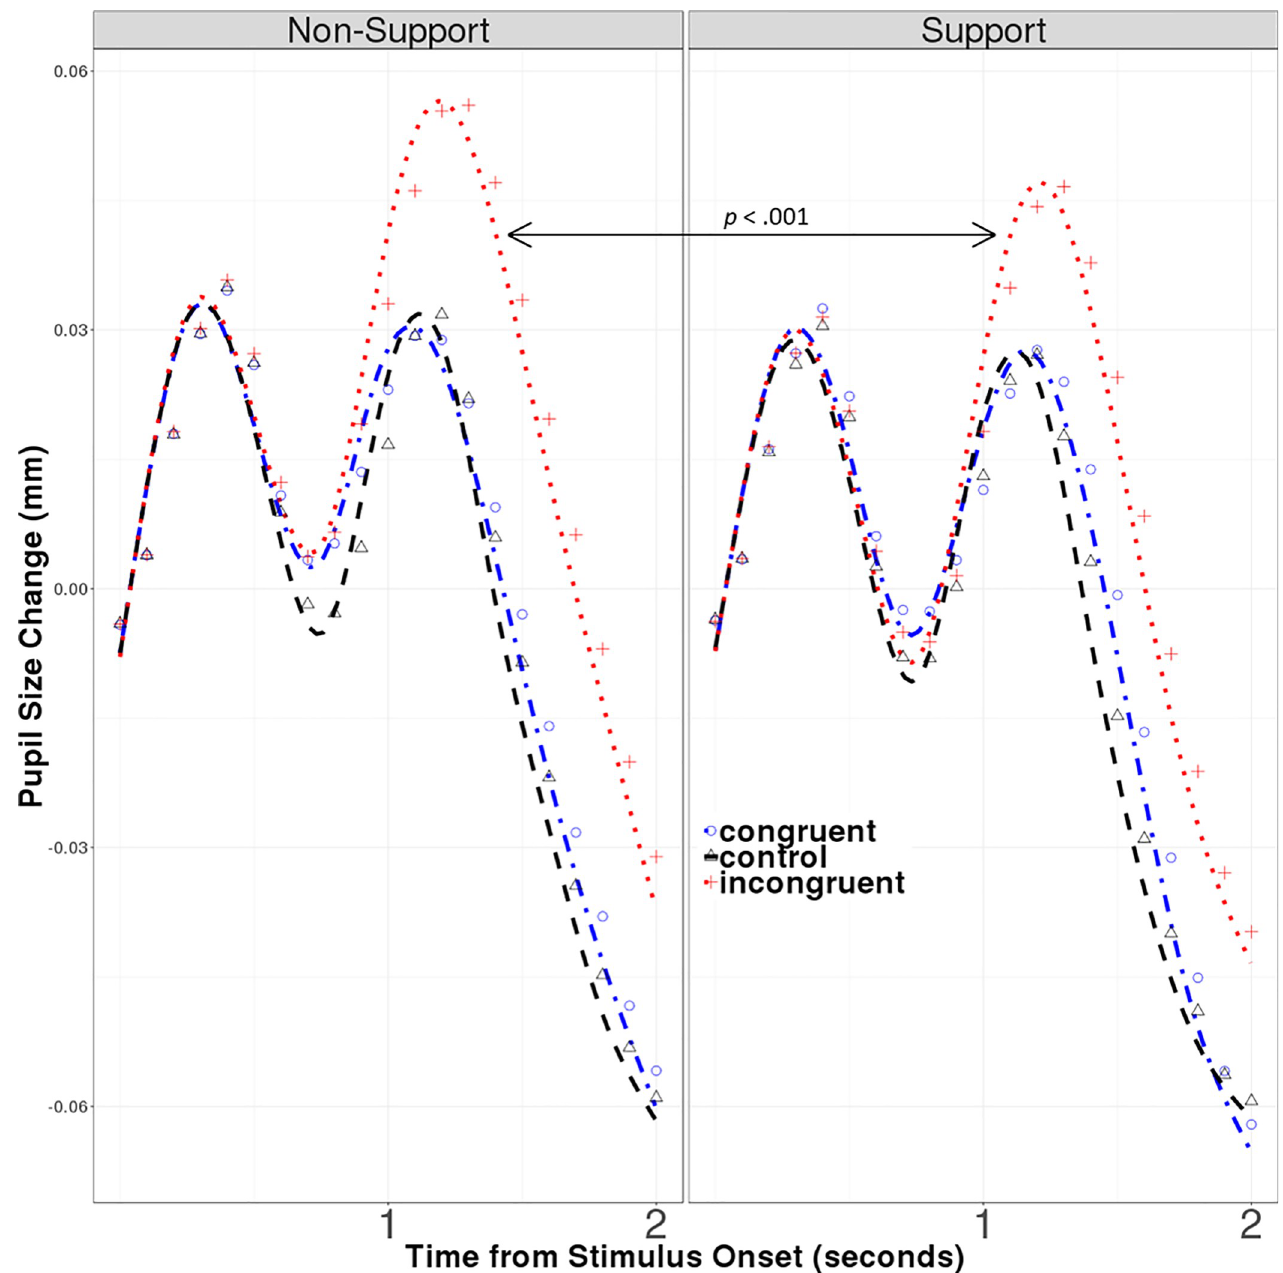
Fig 2. Graph of phasic pupil dilation change represented by raw data. Average pupil dilation change as a response to each individual Stroop task trial shown in millimeters. The data points are binned into 100ms and then averaged for all participants. The graph depicts both support and non-support conditions. The first dilation peak in the fig (from about 0ms - 750ms) represents a reflexive pupillary response to the onset of the visual stimulus (i.e. the appearance of the Stroop stimulus on the screen).The second dilation peak (from 750ms– 2000ms) represents task-specific arousal associated with semantic/evaluative processing of the stimulus. Only the second peak was of interest, so only pupillary data after 750ms post stimulus onset was included in the analysis reported in Table 2. size over time. Fig 2 depicts the pupillary data. Statistical interactions between this Time func- tion and the Stroop Condition (Control, Congruent and Incongruent) reveal differences in the pupillary response to the different types of Stroop stimuli. The critical test of our hypothesis is a three-way interaction of Time, Stroop Condition, and Support Condition, which would